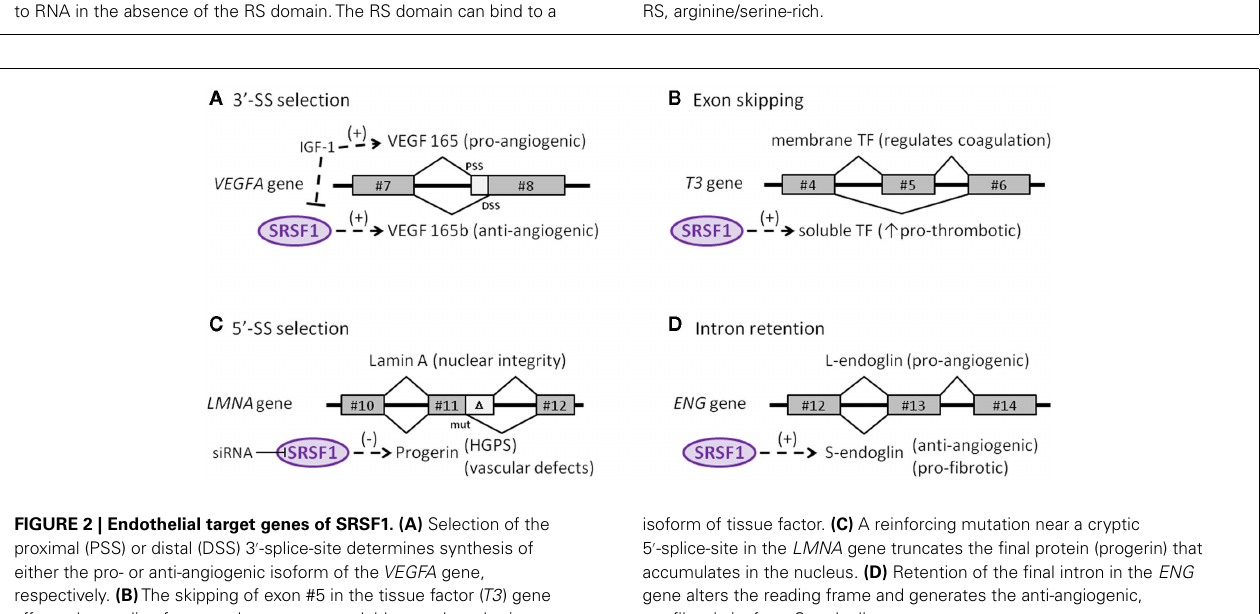
FIGURE 1 |The SR protein family. (A) Scheme representing the level of homology among human SR proteins (Manley and Krainer, 2010), based on the result of a multiple sequence alignment using ClustalW2. Alternate names are in parentheses. Both RS and RRMs are modular domains, which means that RRMs can be exchanged between SR proteins, and may still bind to RNA in the absence of the RS domain.The RS domain can bind to a